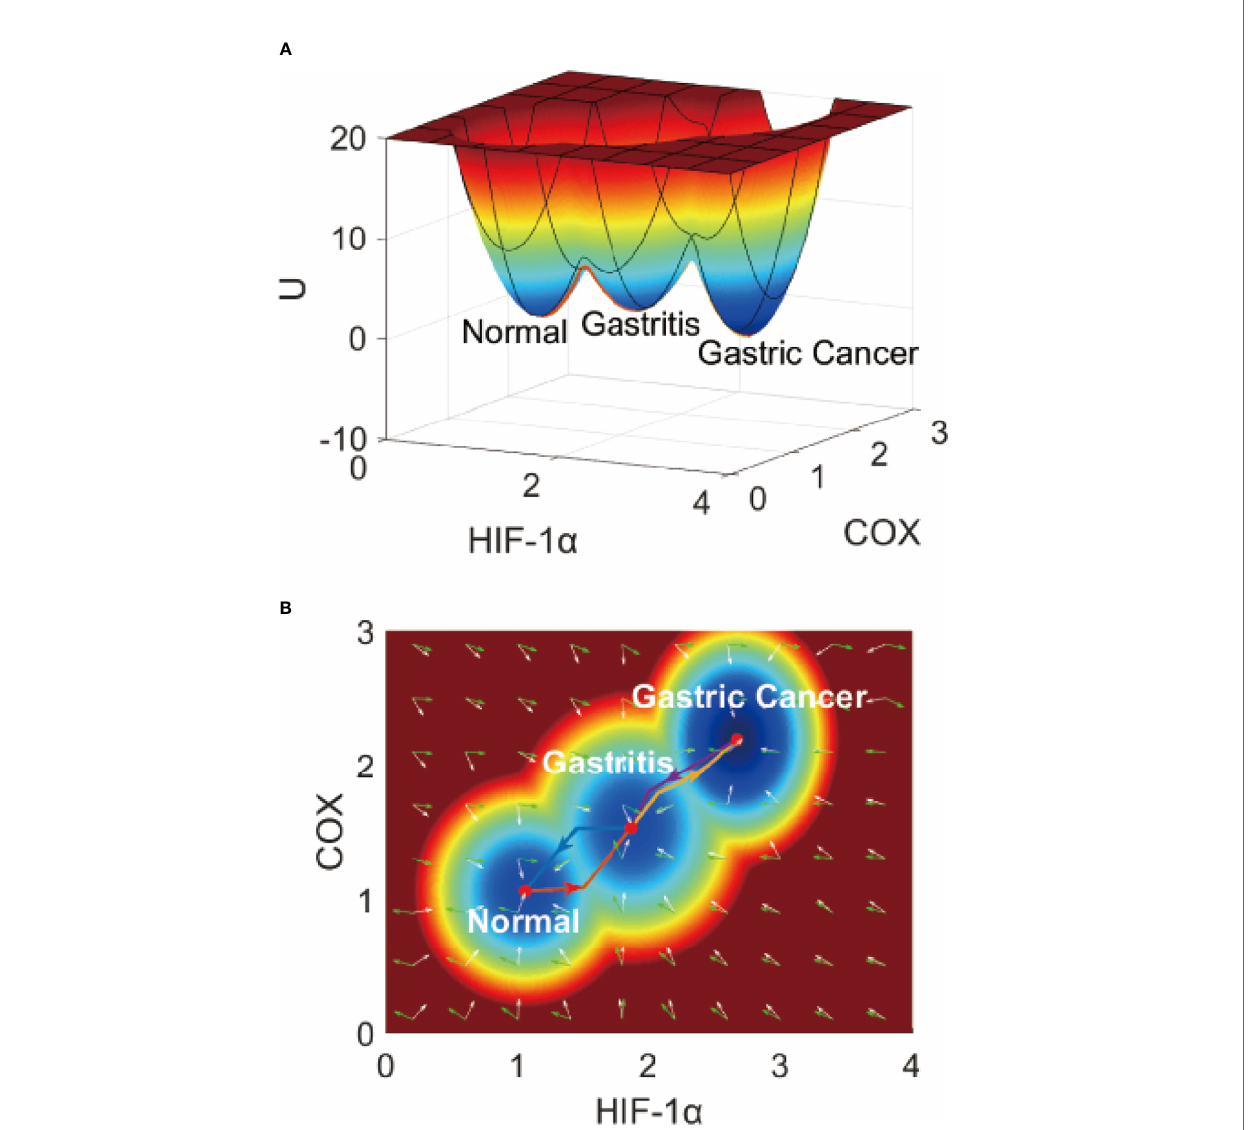
FIGURE 2 | The IGC landscape, which contains three stable states. (A) The 3-dimensional landscape of IGC. (B) The 2-dimensional landscape of IGC. The lines in red, blue, yellow, and purple represent the dominant kinetic path from the normal to the AG state, from the AG to the normal state, from the AG to the gastric cancer state, and from the gastric cancer to the AG state, respectively. The white arrows denote the negative gradient of the potential landscape, and green arrows denote the curl fl ux force of the potential which indicates that the H. pylori infection worsens gastritis and causes further change into intestinal metaplasia. When the term H = 0.2, there are normal and gastric cancer states on the fourth layer of the landscape. The IM and gastric cancer states gradually converge and merge into one. The cancer state becomes the dominant state. When the term H = 0.6, there is only one gastric cancer state on the fi fth layer of the landscape. The normal state disappears and the cancer state is dominant. It is impossible for a patient to recover to their normal state while suffering from H.